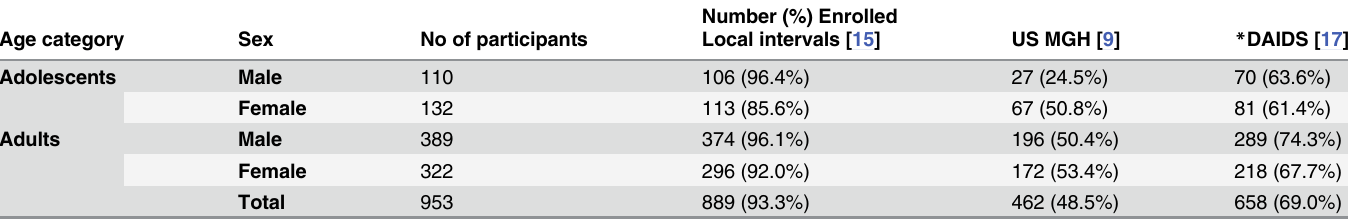
Table 7. Hypothetical enrollment using local reference intervals compared to US-derived reference intervals and the DAIDS toxicity